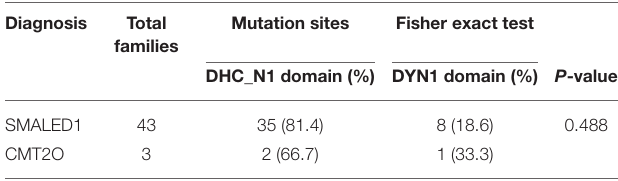
TABLE 1 | Comparison of mutation site distribution between SMALED1 and CMT2O families.